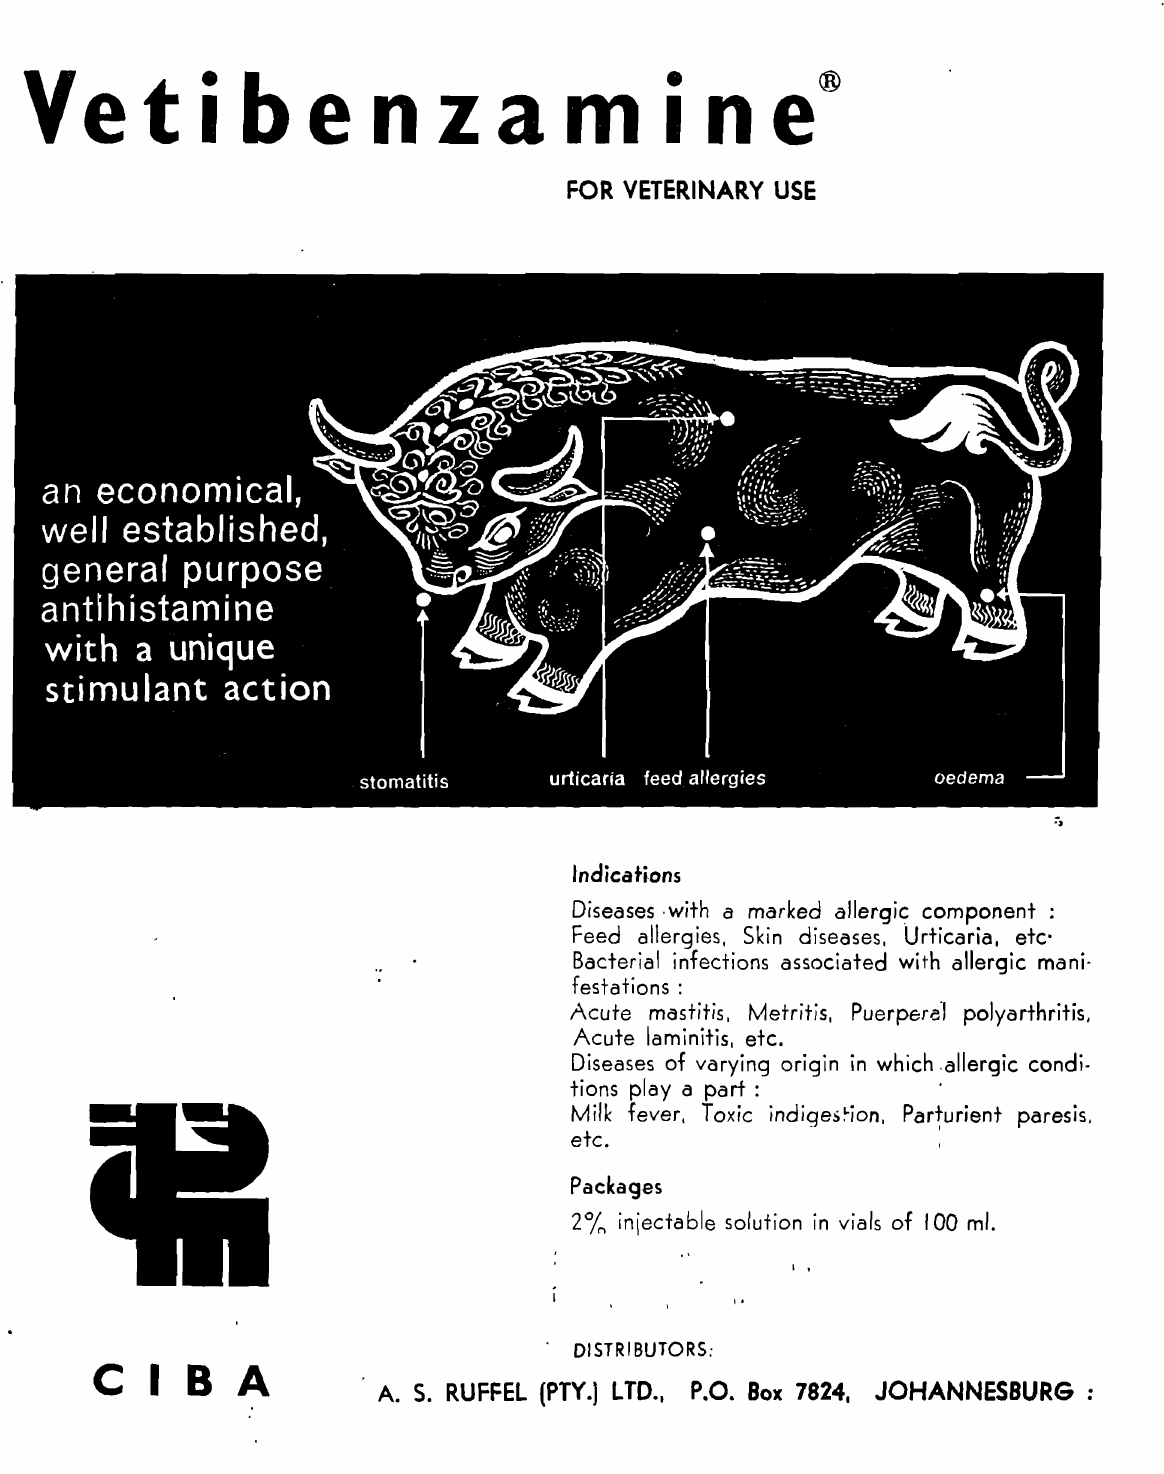
Indications Diseases ·with a marked allergic component: Feed allergies, Skin diseases, Urticaria, etc' Bacterial infections associated with allergic mani festations : Acute mastitis, Metritis, Puerper.:l1 polyarthritis, Acute laminitis, etc. Diseases of varying origin in which .allergic condi- tions playa part: . Milk fever, Toxic indiges~ion, Parturient paresis. etc. Packages 2°/" iniectable solution in vials of 100 ml. . ,